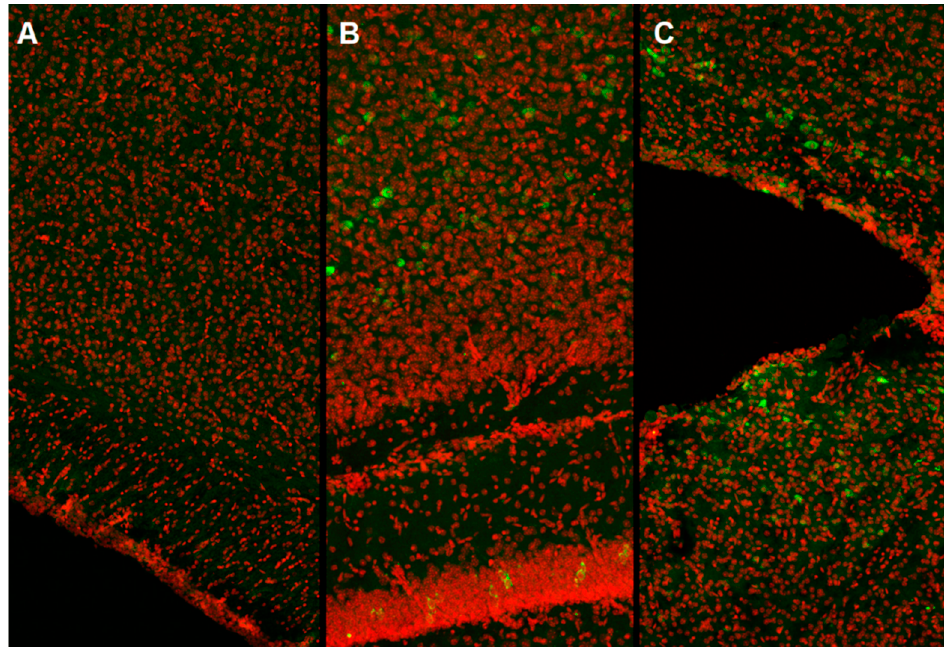
Figure 1. Representative confocal images of eGFP fluorescent protein expression in mouse brain slices after transduction with the AAV-vector: ( A )—Intact, ( B )—AAV-Syn-BDNF-eGFP, ( C )—AAV-Syn-GDNF-eGFP. Red—DAPI, Green—eGFP. Image size 640 × 1920 µm. A laser scanning microscope LSM 800, Plan-Apochromat 10×/0.3 objective (Zeiss, Oberkochen, Germany) was used for the imaging.